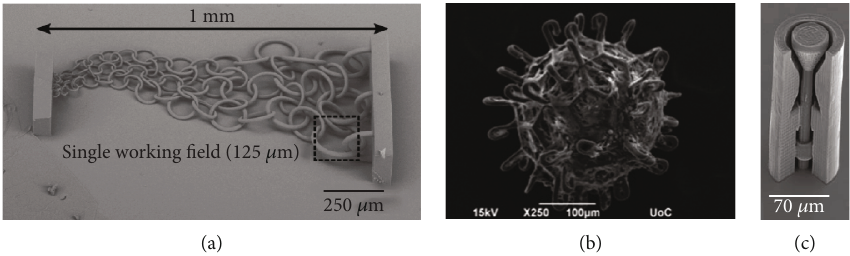
Figure 13: (a) A gradient chainmail-like structure which could be used as a mechanically fl exible sca ff old while still being made out of hard material. The mm scale size is su ffi cient for usage in real clinical trials. It is important to note that it was done using a galvo scanner and linear stage synchronization allowing to avoid stitching. It would have been detrimental to the mechanical quality of the structure (Adapted with permission from [6] © The Optical Society.). (b) Burr-like ball seeded with cells. Due to the geometry of the structure and hook-like outer ends, multiples of such objects can join together in the wound forming a shape-replicating structure (Reproduced from [113], with the permission of American Vacuum Society.). (c) Example of a passive microvalve allowing the fl ow of liquid only in one direction. Enhanced and custom-tuned objects of this kind could potentially be used in the veins to replace worn out biological analogs (adopted from